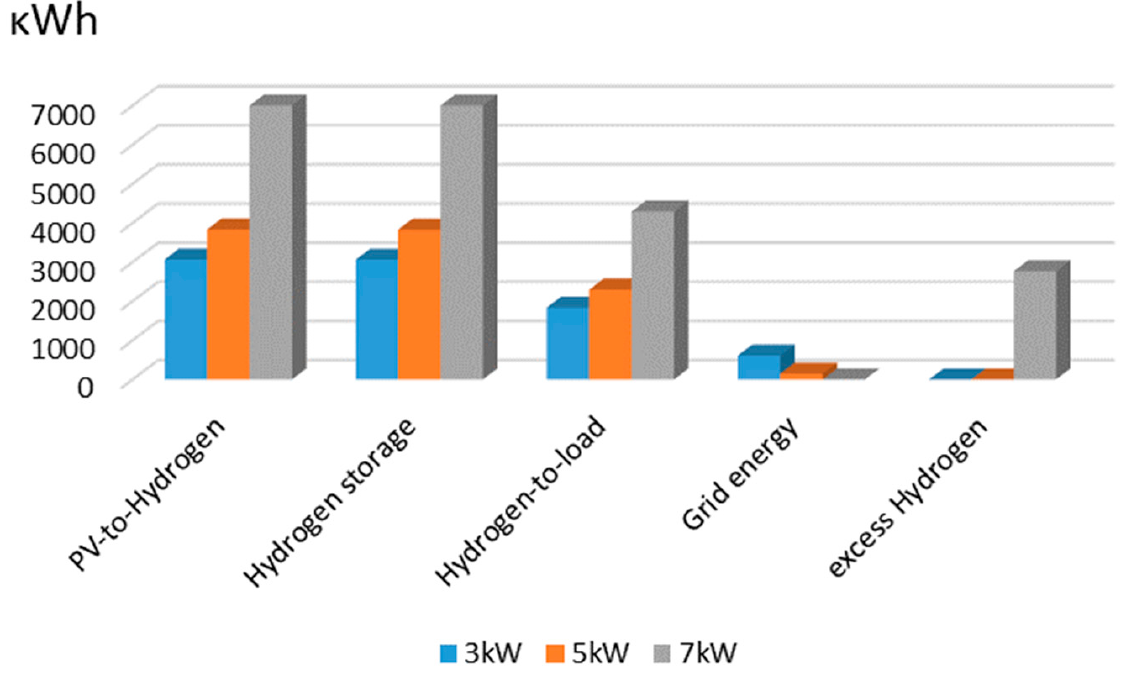
Figure 9. Simulation results in the presence of TSBB converter.